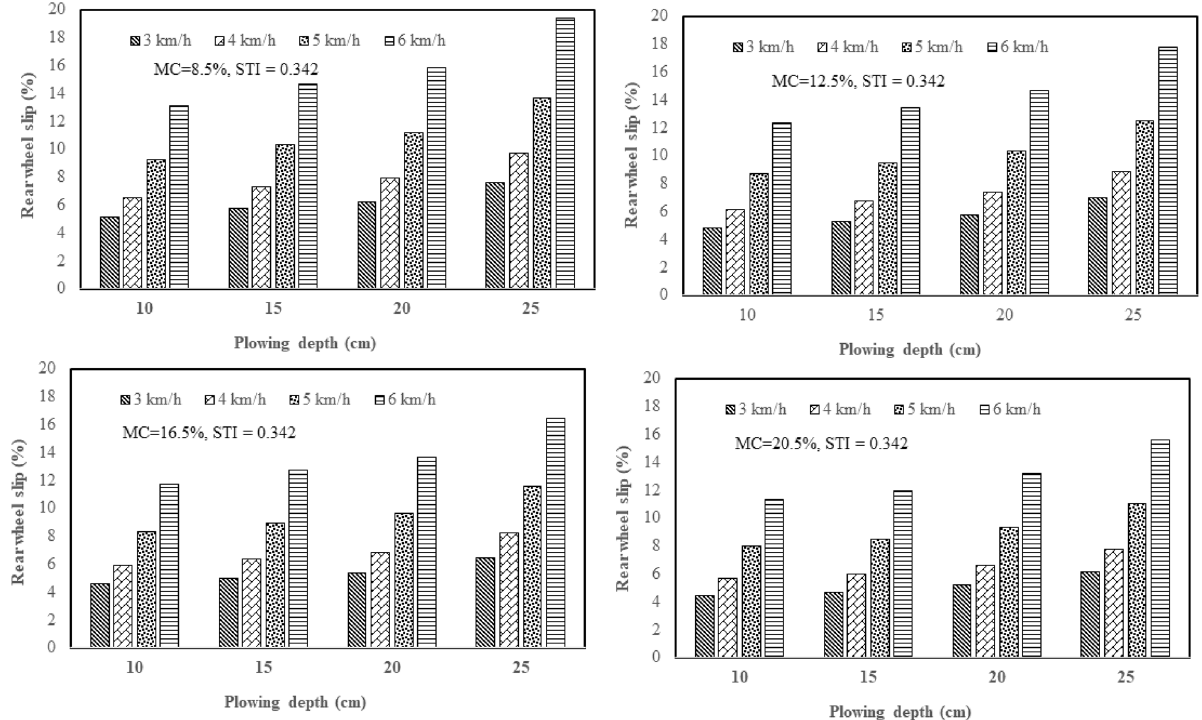
Figure 9. Effect of plowing speed and depth on the tractor rear wheel slip in 2WD mode at different levels of soil moisture content during plowing process by disk plow in soil with a texture index of